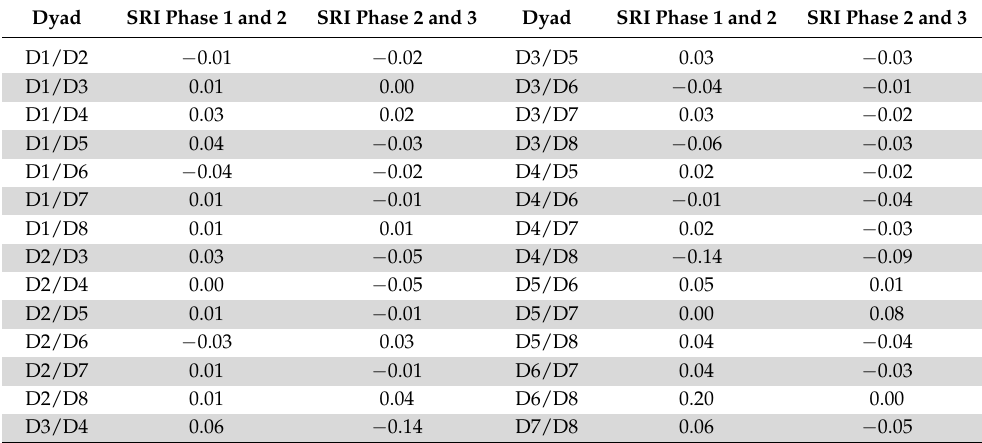
Table 5. Mean difference for the simple ratio index (SRI) values between Phase 1 and 2 and Phase 2 and